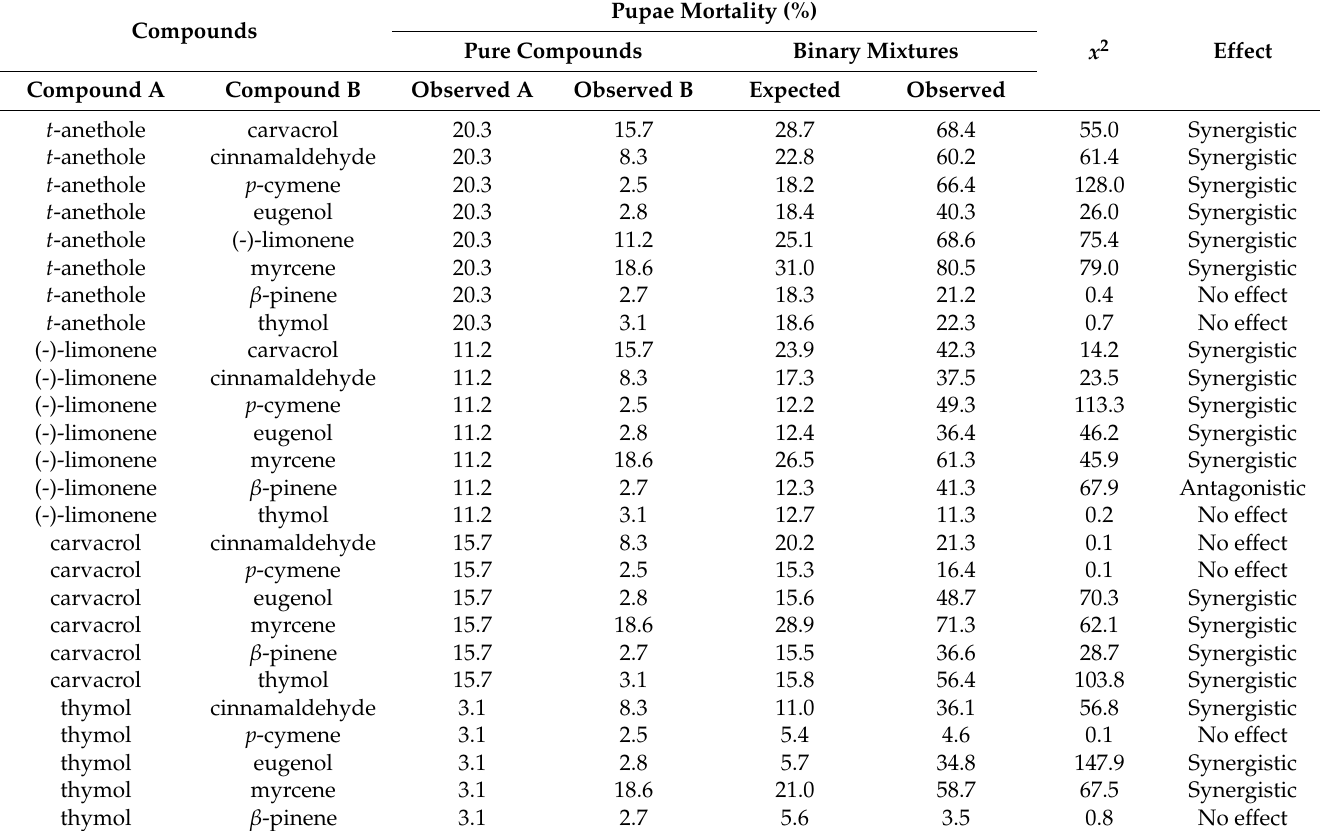
Pupae Mortality (%)